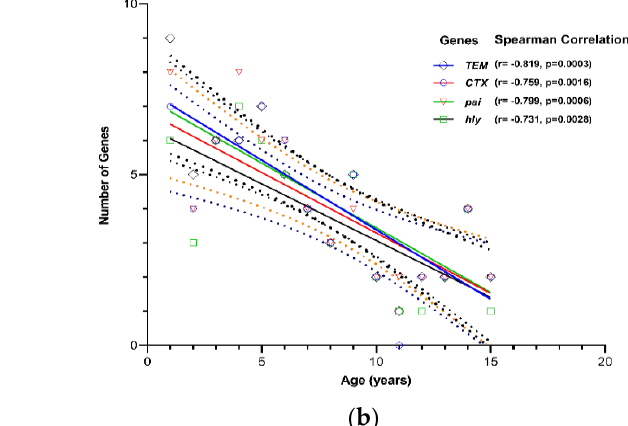
Figure 3. Correlation analysis between the children of all ages and UTIs by UPEC. The correlation analysis indicates that the number of UTIs reduces with children’s age, and hence this figure uses a number so that the relationship is evident across ages from 0 to 15 years. Each marker denotes a sum observation of UTIs for a particular age of the children . Spearman’s correlation was performed by GraphPad Prism, and significance was considered to be established when p > 0.05.